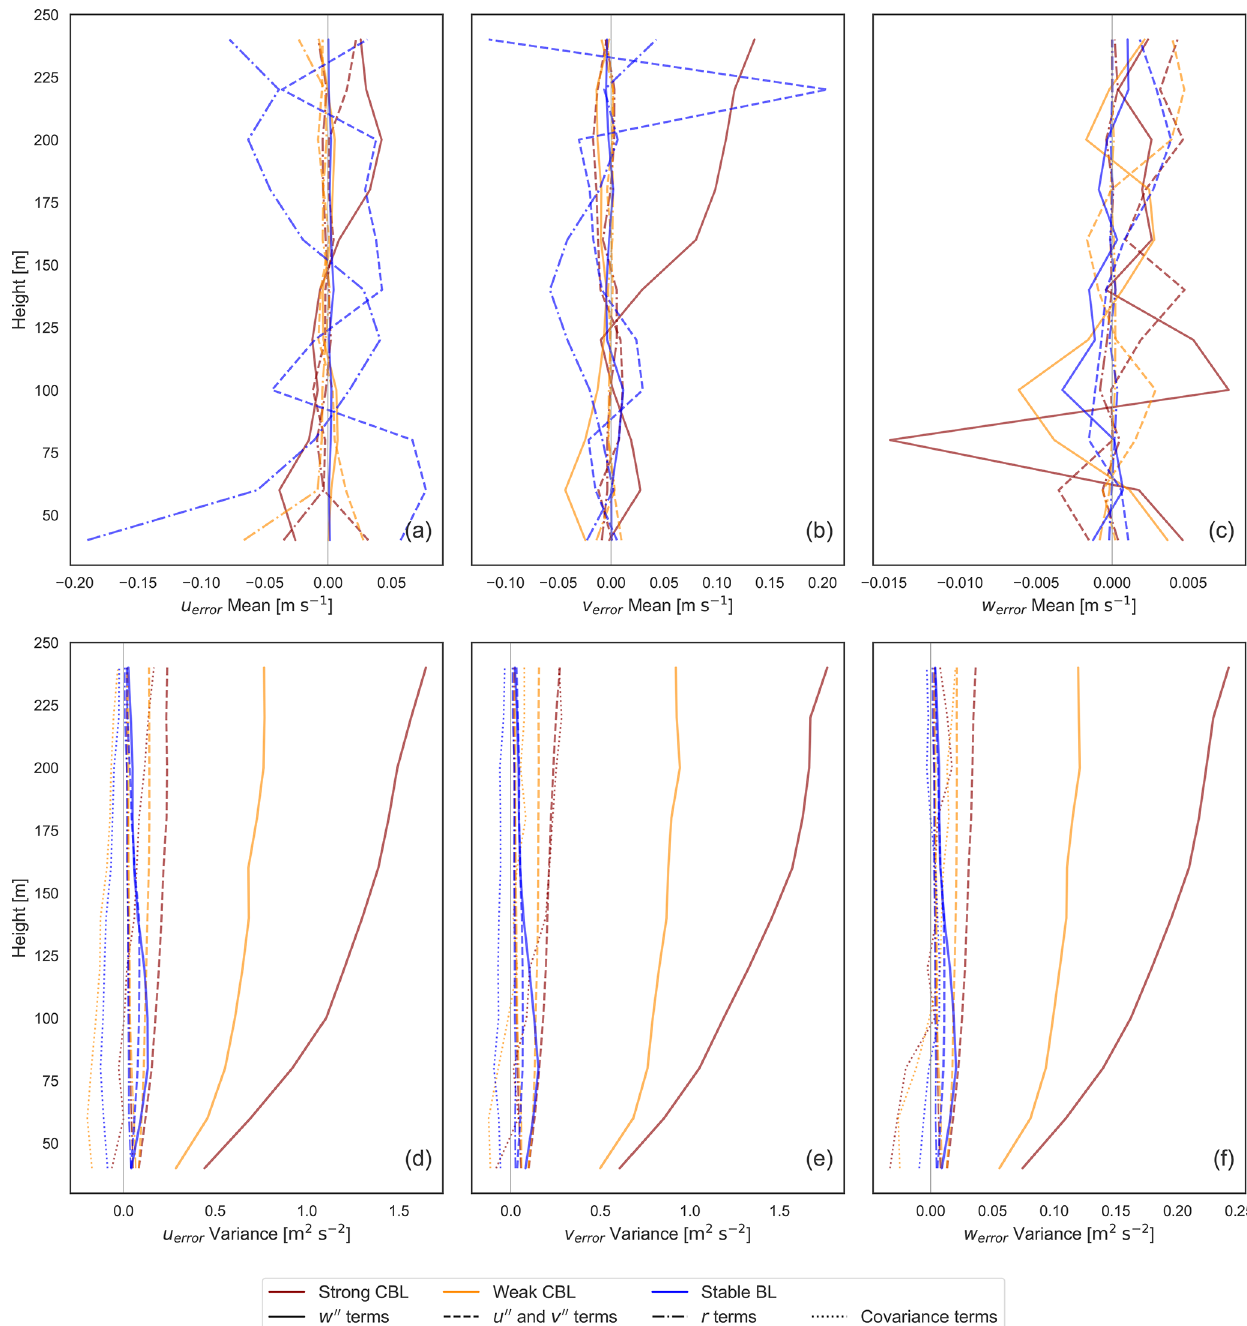
Figure 8. Contributions to the mean (a, b, c) and variance (d, e, f) of the error for each wind component, partitioned according to Eqs. (12)– (15) into horizontal ( u (cid:48)(cid:48) ,v (cid:48)(cid:48) ) and vertical ( w (cid:48)(cid:48) ) velocity perturbations, RWF effects ( r ), and combined covariance effects.